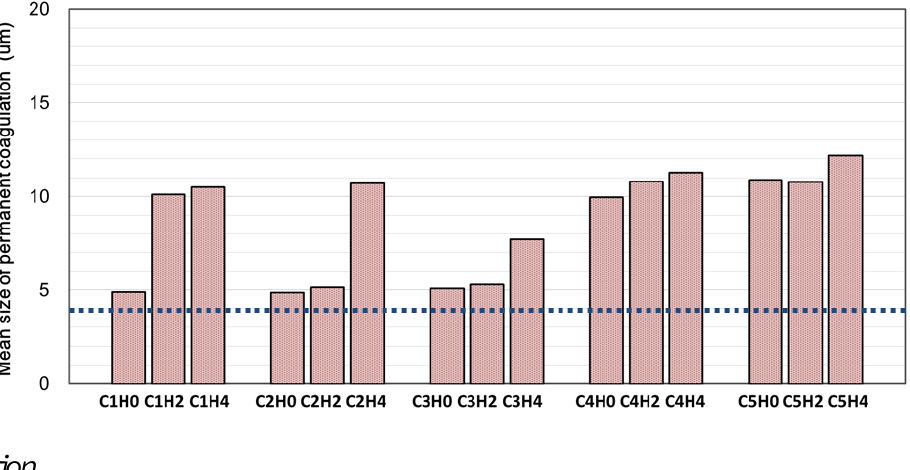
Figure 6. Mean size of permanent coagulation (the dotted line is the mean of cement powder (µ ), 3.84 c